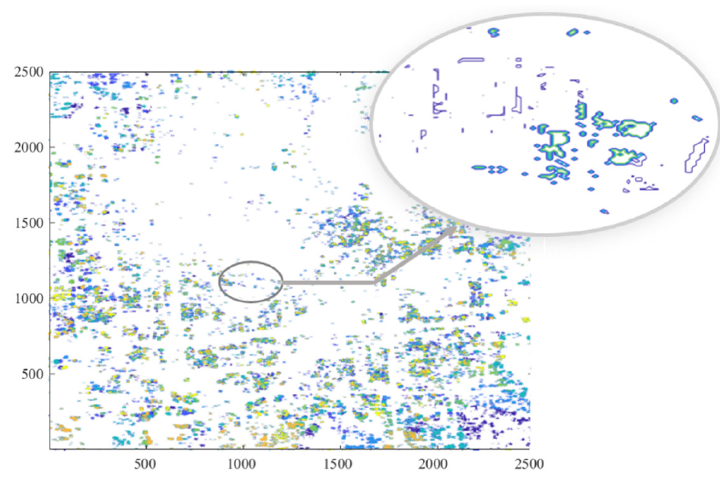
Figure 4. Distribution result of the weak coverage points after clustering.